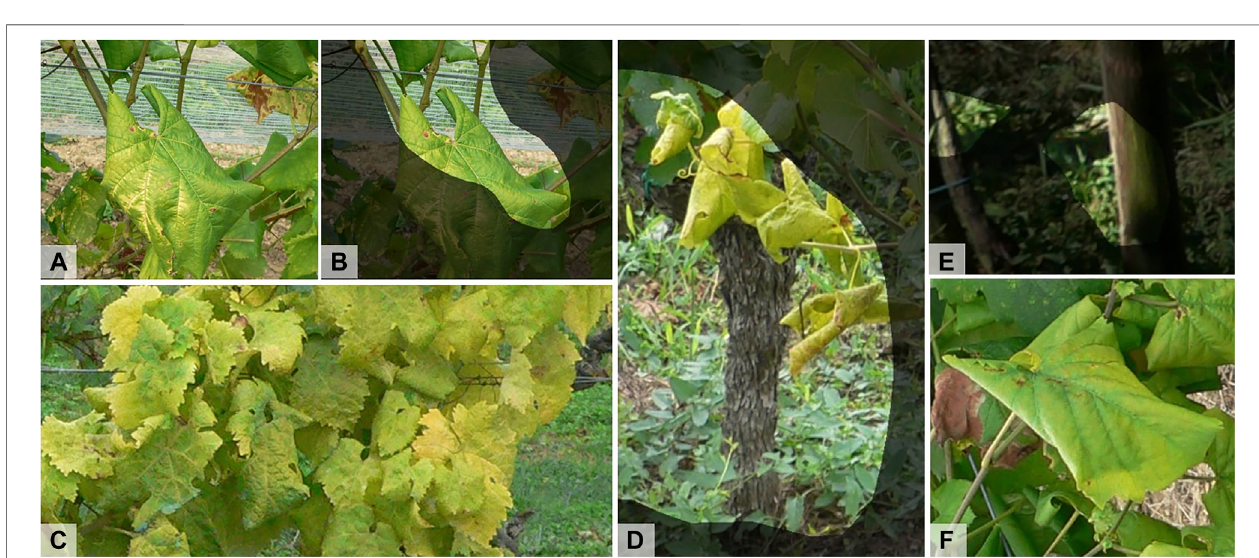
FIGURE 7 | Examples offalse predictions from Ext. datasets. (A) Original image of Exalta leaf with Flavescence dorée (FD) symptoms; (B) Prediction associated to imageA,onlytherolledareasoftheleafareidenti fi edasFD; (C) UndetectedFDsymptomsonUgni-Blancgrapevinevariety; (D) Over-detectionclosetoFDsymptomatic areas; (E) False detection on non-grapevine elements; and (F) Undetected FD symptoms on Exalta grapevine